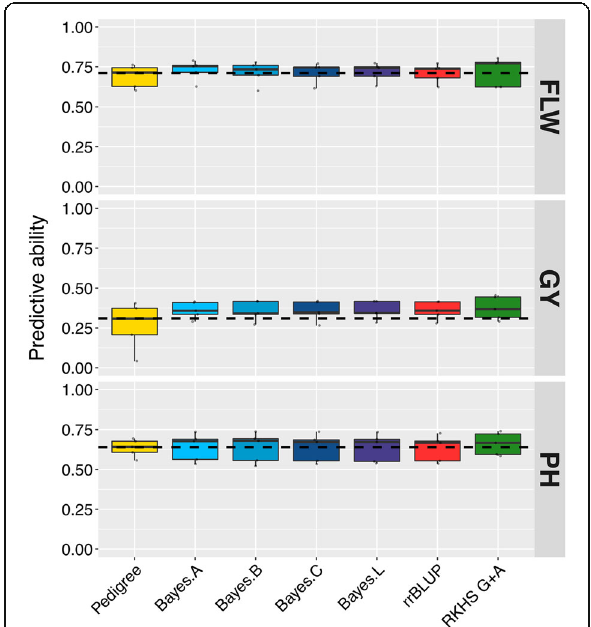
Fig. 5 Prediction abilities of genomic selection models for FLW, GY and PH based on 5 fold cross-validation using the 1k-RiCA. Average predictive abilities across 5 fold stratified cross validations experiments ( k =5) using 353 rice lines measured for flowering time (FLW), grain yield (GY), and plant height (PH) for seven different statistical models; Pedigree BLUP (Pedigree), BayesA, BayesB, BayesC, BayesLasso (Bayes L), rrBLUP (ridge regression) and RKHS using genomic and pedigree relationship matrices (RKHS